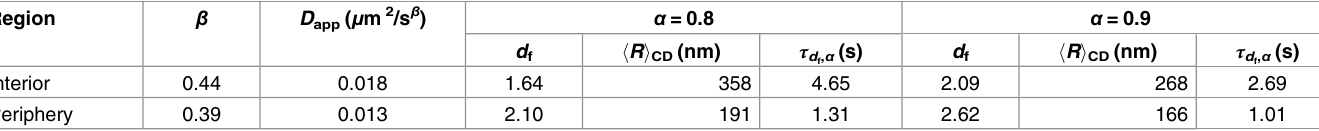
The exponent β and the apparent diffusion coefficient D app are obtained by fitting of the MSD results at the interior and periphery regions (Fig 2C). In the calculation, we used the following values: h N i CD = 5000 nucleosomes, γ α ! 1 = 4 k B T / D EGFP and D EGFP = 20.6 μ m 2